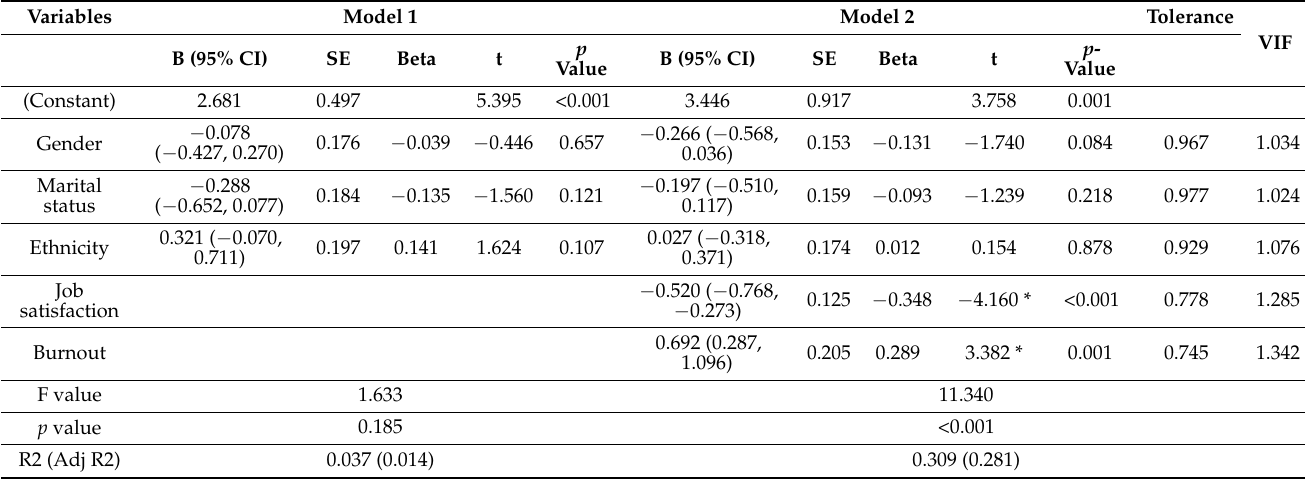
Table 7. Results of Hierarchical Regression Analysis for Intention to